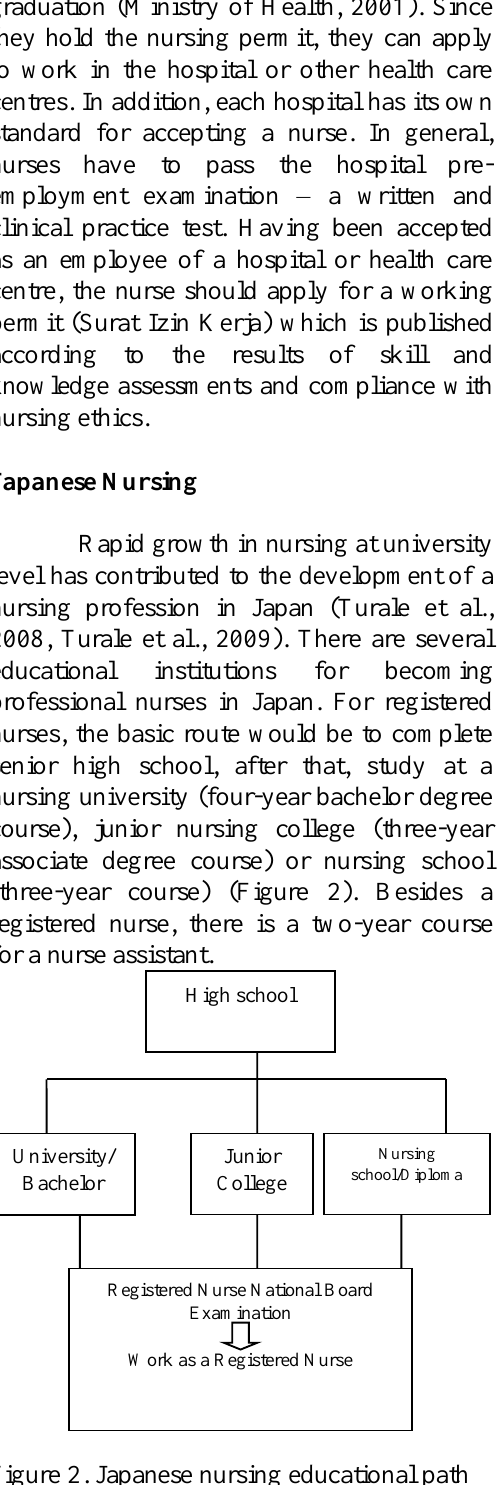
Figure 2. Japanese nursing educational